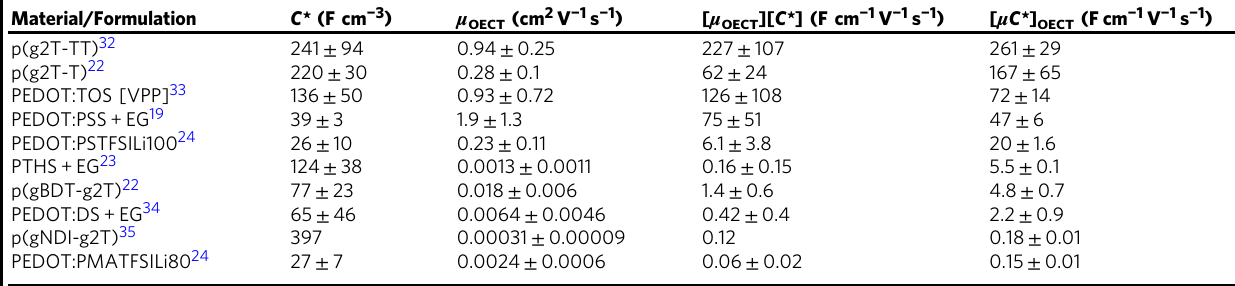
Table 1 Materials fi gure of merit for various OECT materials Material/Formulation